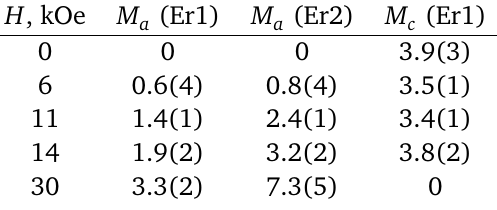
only refers to the ferromag- a component represents c